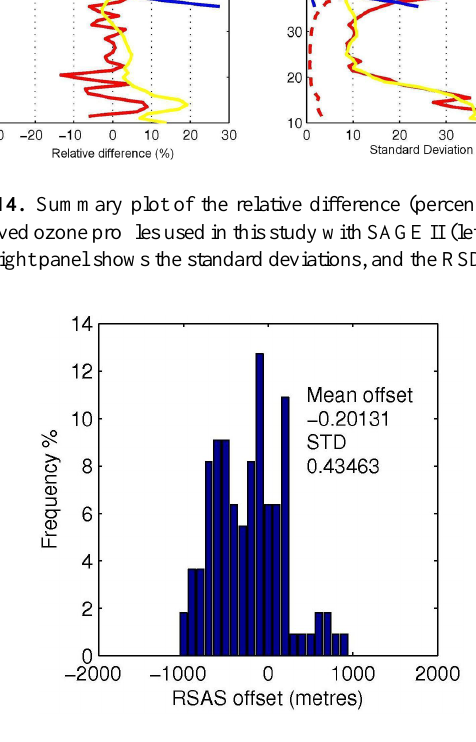
Fig. 15. Histogram of all detected tangent height